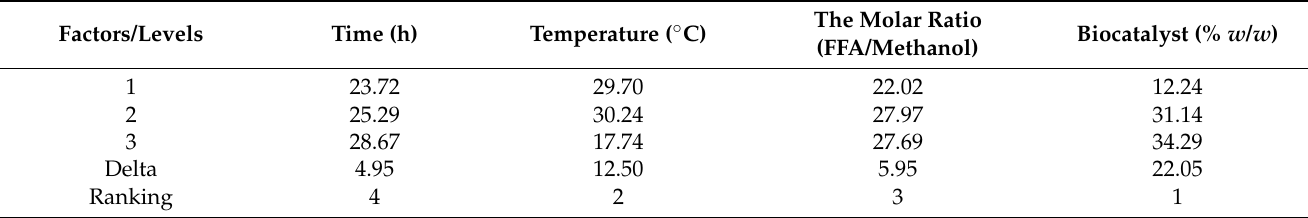
Table 2. Response to the averages of the S/N